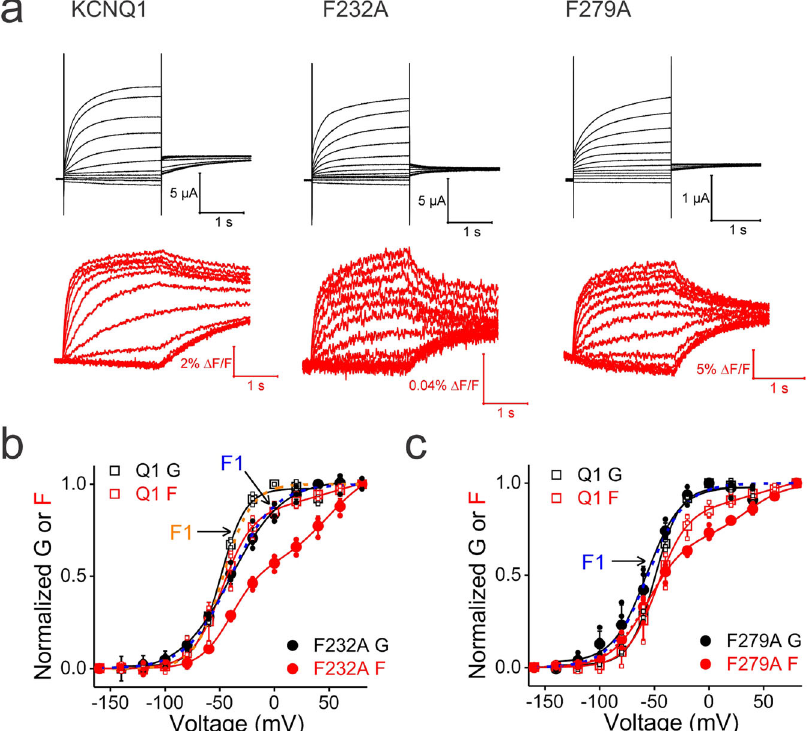
Fig. 5 F232A and F279A do not change the VSD – PD coupling of KCNQ1 in the absence of KCNE1. a Current (black) and fl uorescence (red) traces from oocytes expressing KCNQ1, KCNQ1-F232A, and KCNQ1-F279A channels without KCNE1 association. The voltage protocol is indicated in Fig. 2. b Voltage dependence of currents (black) and fl uorescence (red) from KCNQ1 (squares) and KCNQ1-F232A (circles) channels. F1 indicates the fi rst fl uorescence component from KCNQ1 (orange dashed line) and KCNQ1-F232A (blue dashed line) channels. Only F1 is shown for clarity. c Voltage dependence of currents (black) and fl uorescence (red) from KCNQ1 (squares) and KCNQ1-F279A (circles) channels. F1 indicates the fi rst fl uorescence component from KCNQ1-F232A channels (blue dashed line). Data are shown as mean ± SEM. N is shown in Supplementary Table